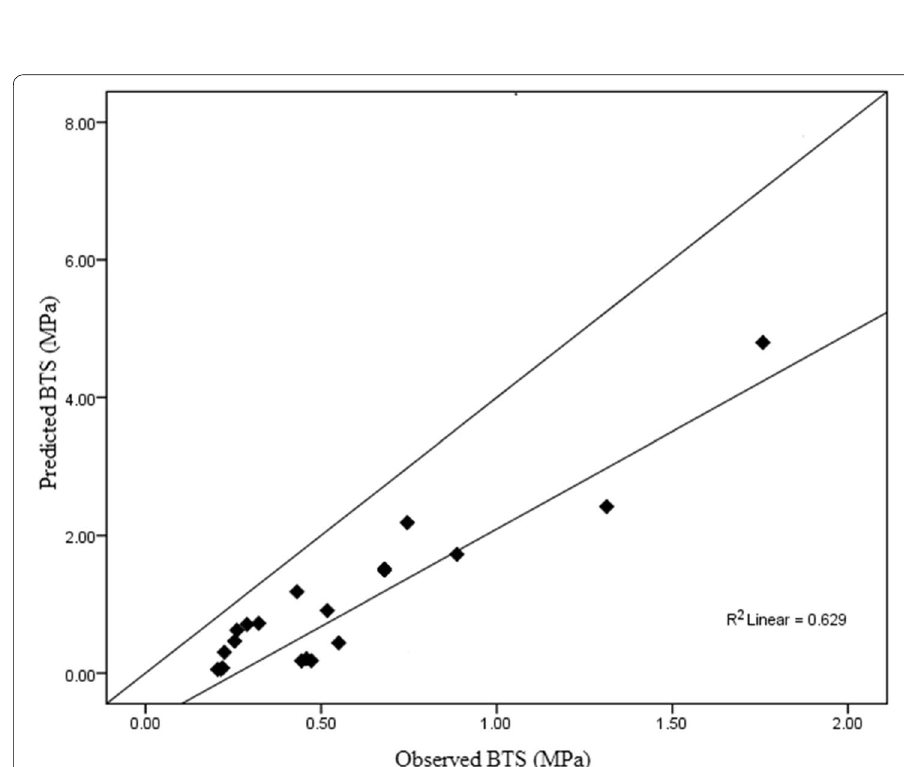
Fig. 6 Cross-correlation of predicted and observed values of BTS for ANN model